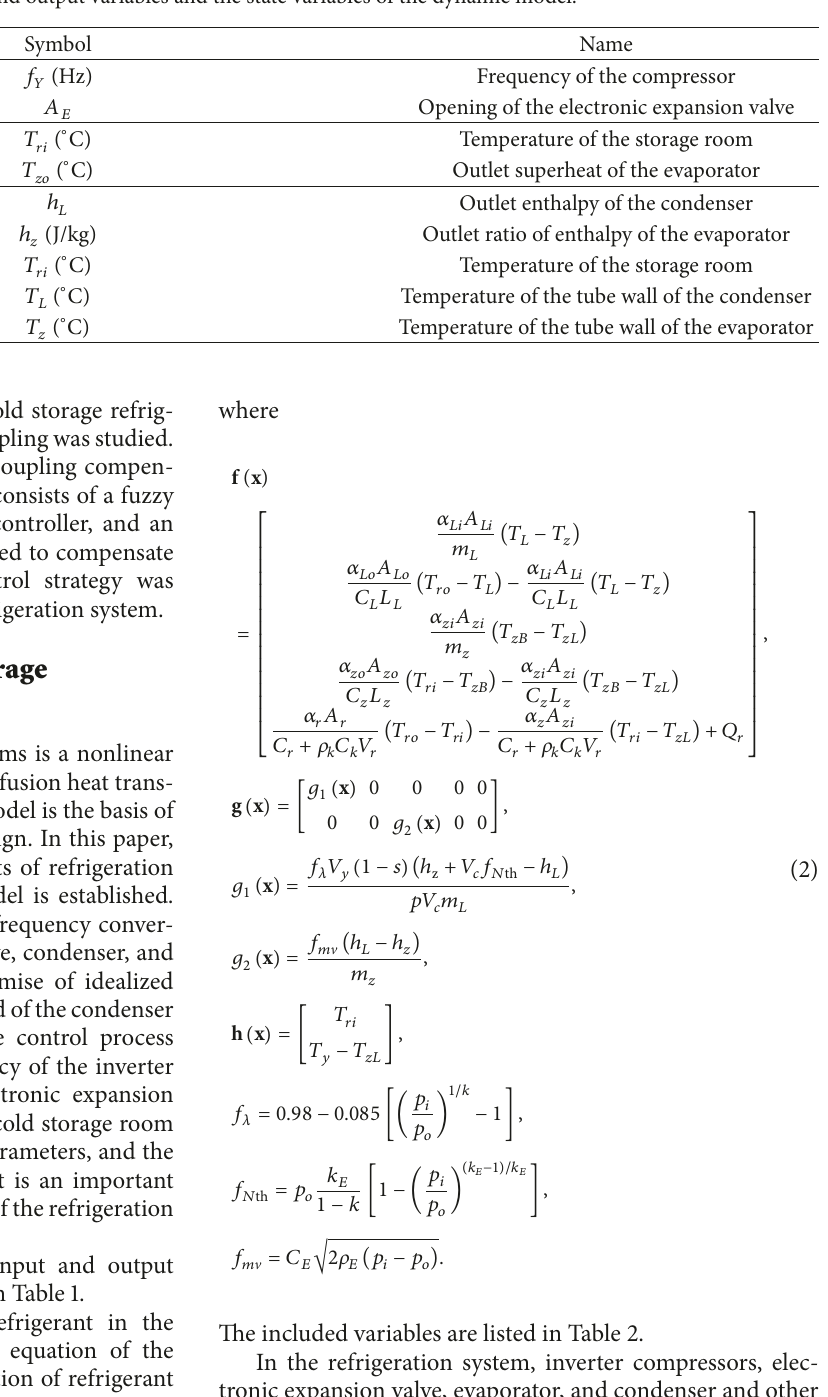
Table 1: The input and output variables and the state variables of the dynamic